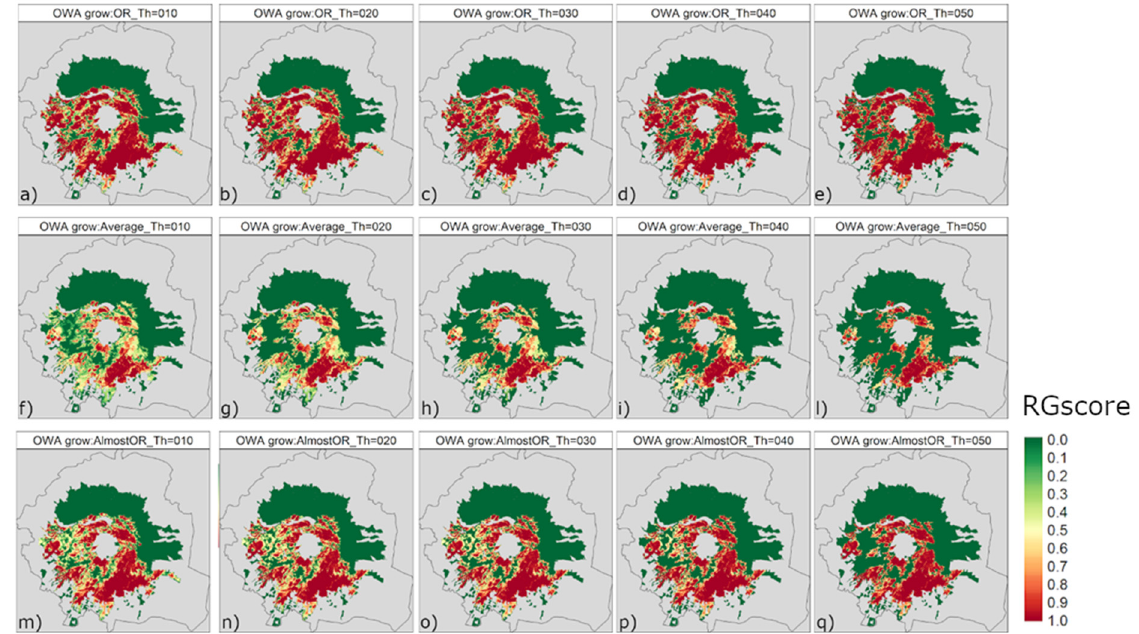
Figure A2. RG output score [0, 1] estimated over the Vesuvius training site OWA AlmostOR ( a – e ), OWA Average ( f – l ) and OWA AlmostOR ( m – q ) as growing boundaries and different threshold for identifying growing boundaries (Th) in [0.1–0.5] (left to right columns). Masked areas are in gray. In all cases the seed layer is OWA AND > 0.9.